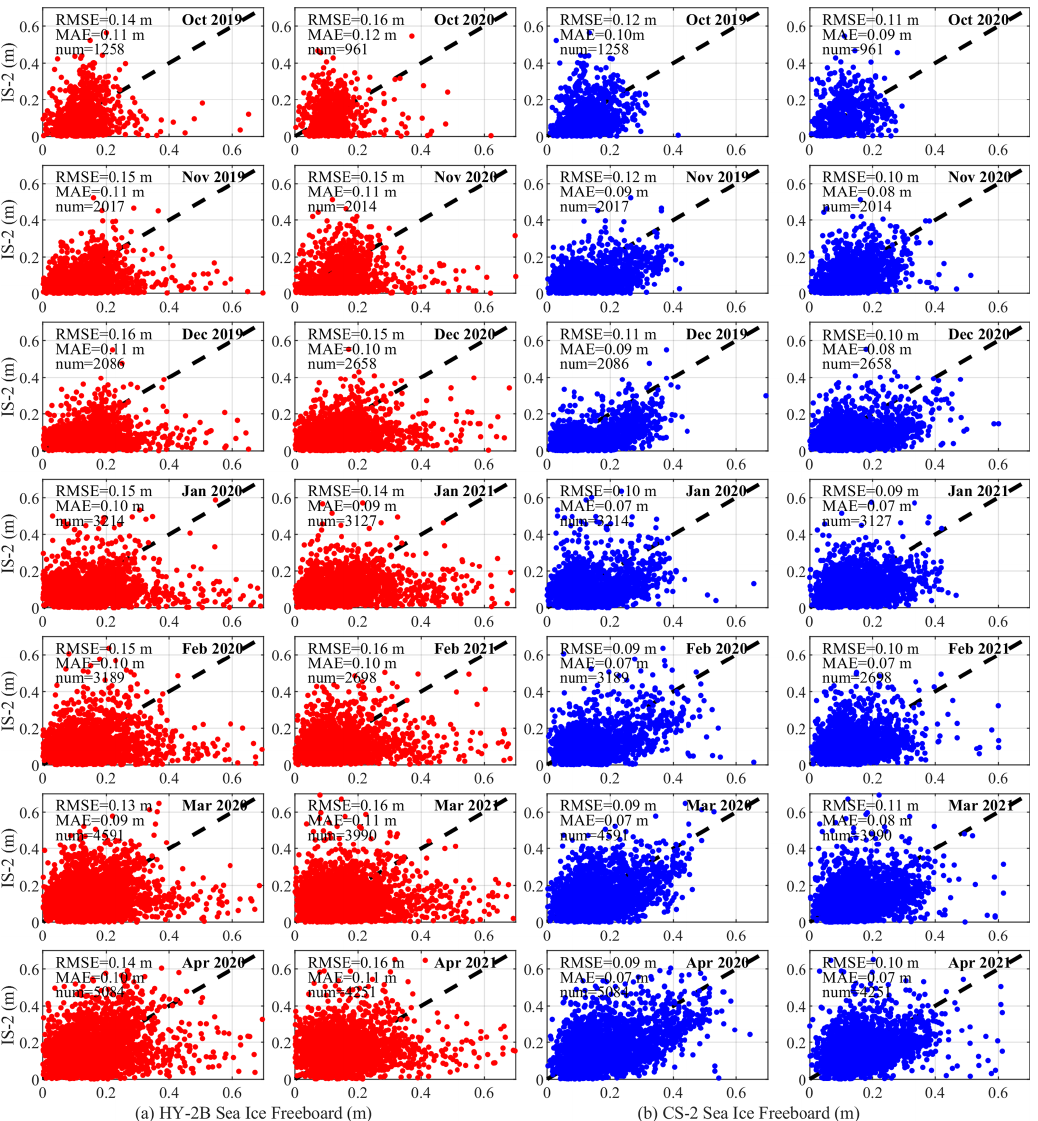
Figure 9. Monthly comparisons between HY-2B sea ice freeboard and ICESat-2 sea ice freeboard and between CryoSat-2 sea ice freeboard and ICESat-2 sea ice freeboard values: panel (a) shows comparisons between HY-2B and ICESat-2 in red points, and panel (b) shows comparisons between CS-2 and ICESat-2 in blue